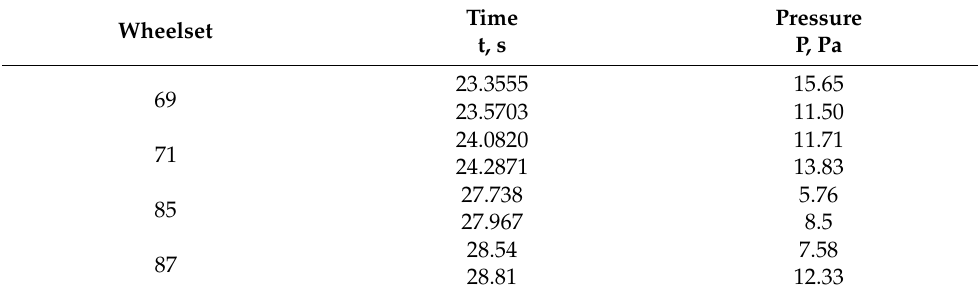
Table 6. Results of sound pressure measurements.